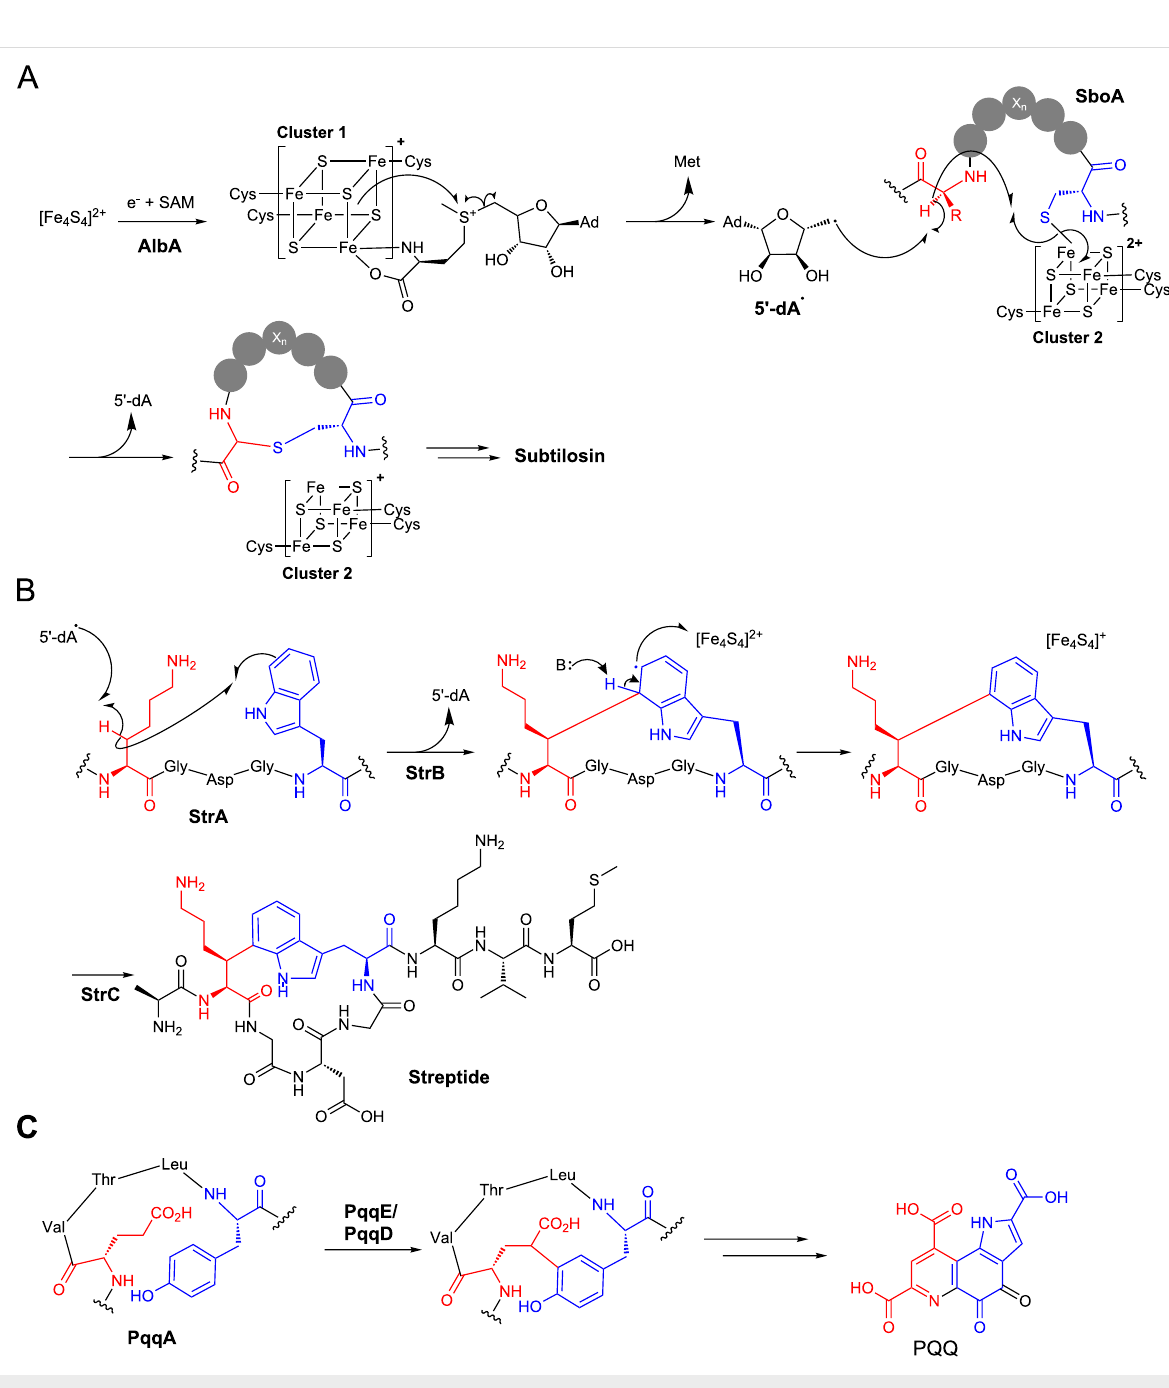
Figure 10: Radical cyclisation in RiPP biosynthesis. A) AlbA-catalysed formation of thioethers in the biosynthesis of subtilosin. The mechanism for deoxyadenosine radical formation is consistent throughout most radical SAM enzymes. B) Mechanism of carbon–carbon cross-linking in streptide bio- synthesis. C) Proposed carbon–carbon bond formation by SPASM protein PqqE in the biosynthesis of pyrroloquinoline quinone